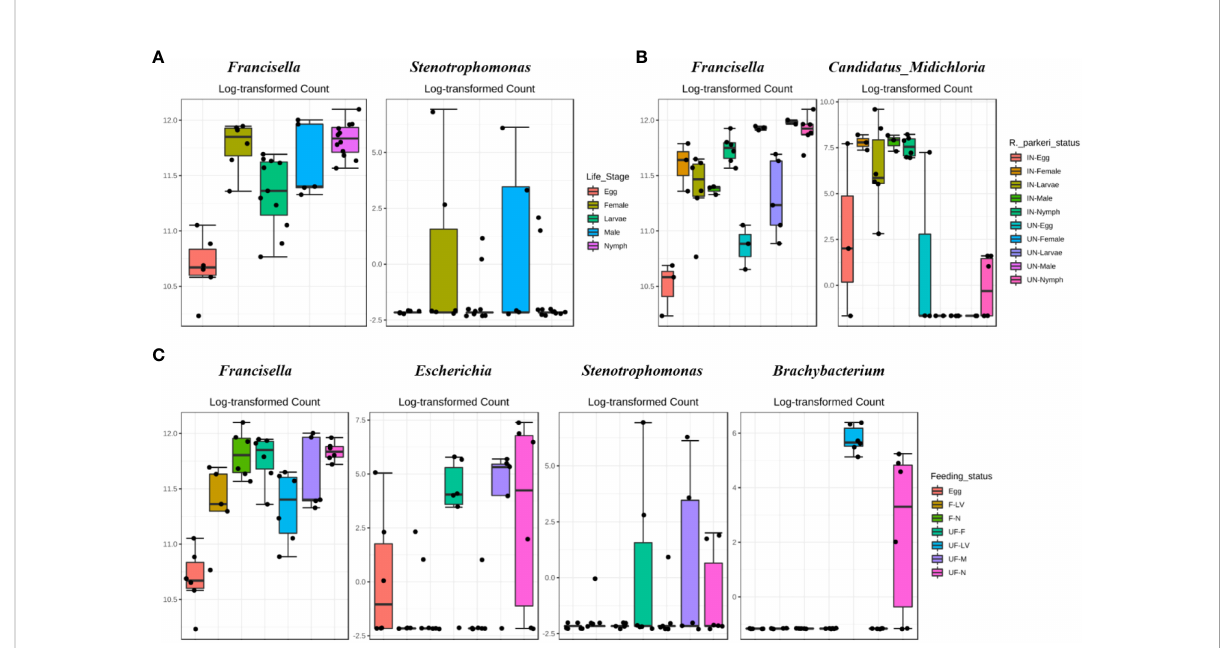
FIGURE 2 DeSeq2 differential abundance analysis of OTUs (genus-level) between (A) all life stages (B) R. parkeri infected and uninfected, and (C) unfed and partially fed Am. maculatum. For multiple comparisons an estimate of the FDR was calculated to determine differentially abundant families with a signi fi cance threshold of p-value < 0.05. IN ( R. parkeri infected), UN (uninfected), F (blood fed), UF